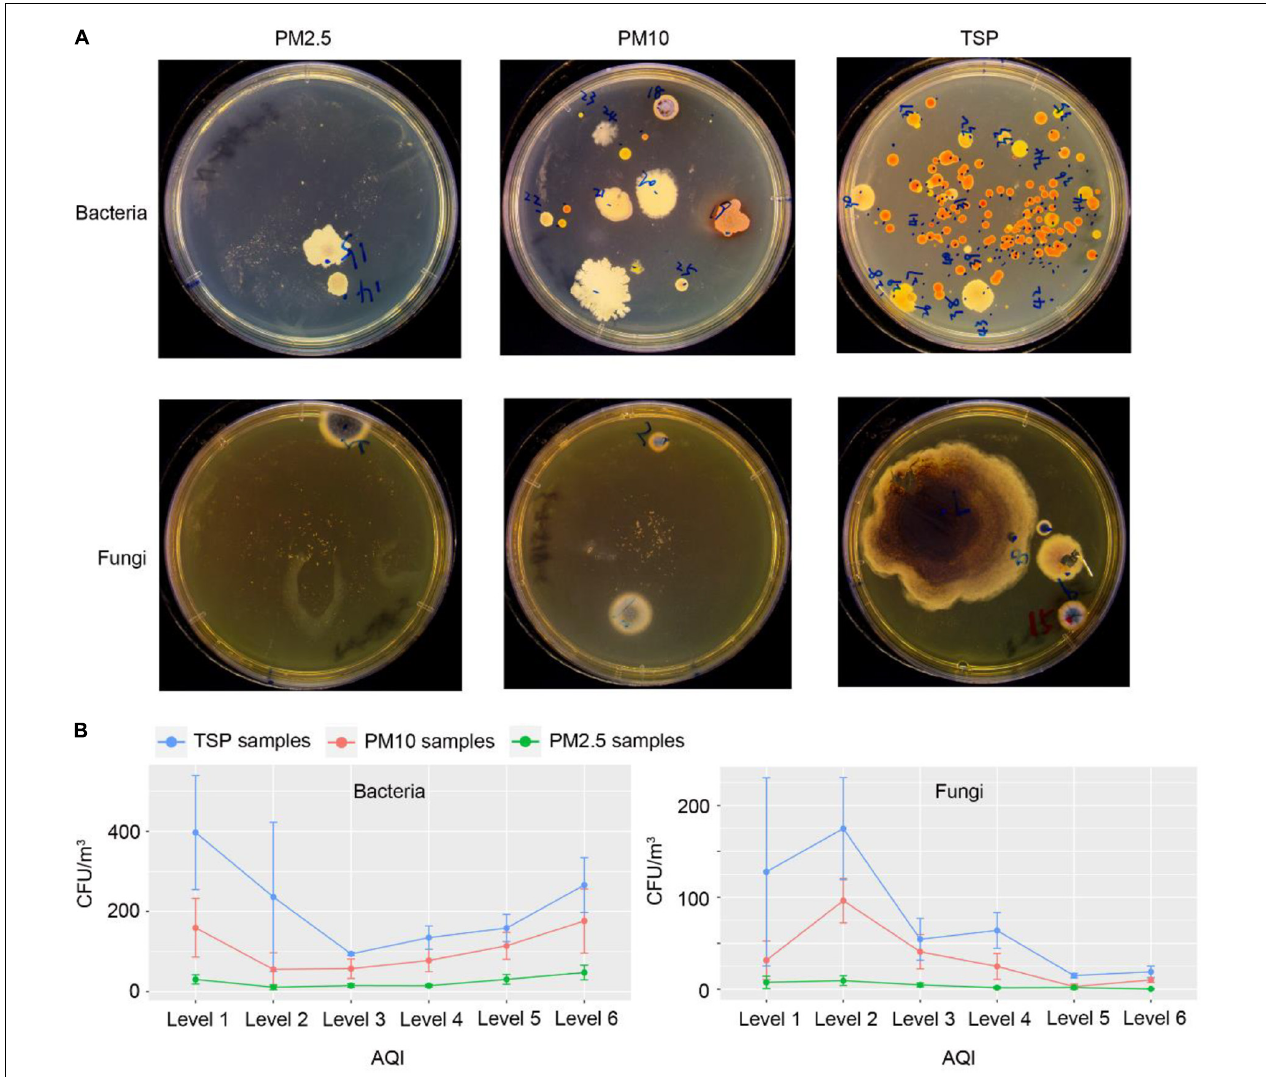
FIGURE 1 | Summary of PM samples and isolation numbers of microbial colonies during various haze-level days. (A) Example nutrient agar medium and sabouraud dextrose agar medium showing colony morphologies. (B) Concentrations of microbial colony forming units (CFU) in different PM samples during various haze-level days, Values shown as mean ± standard error